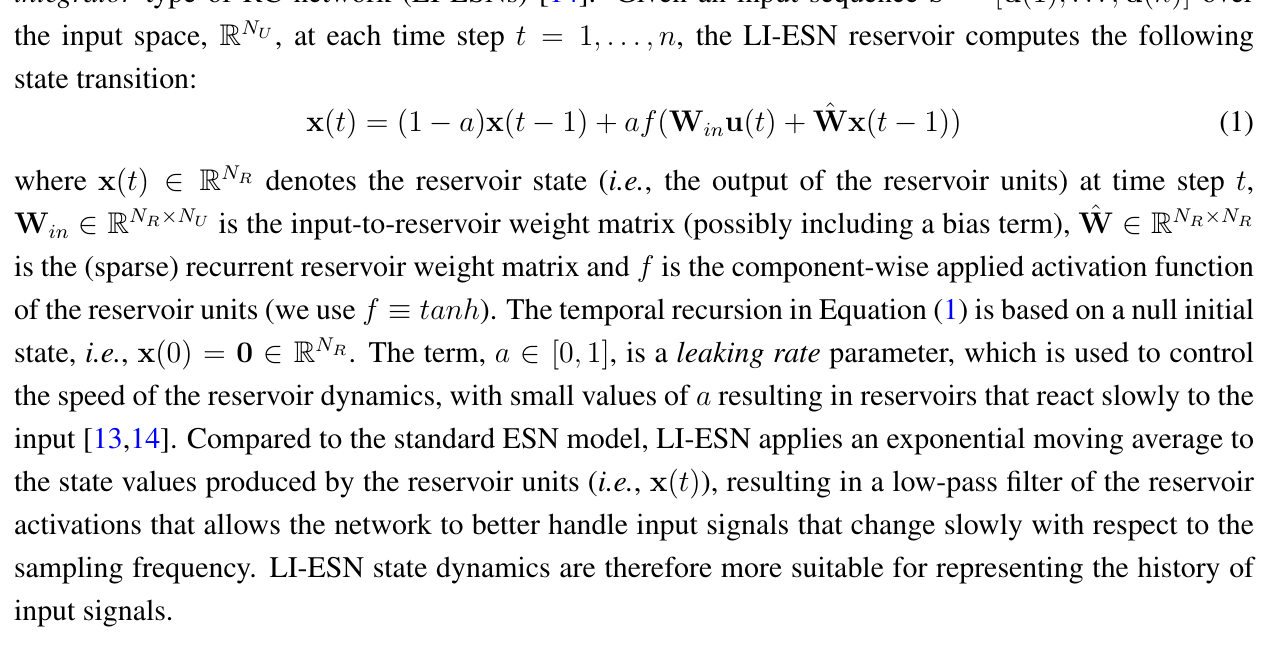
, ˆ W and W denote the in out